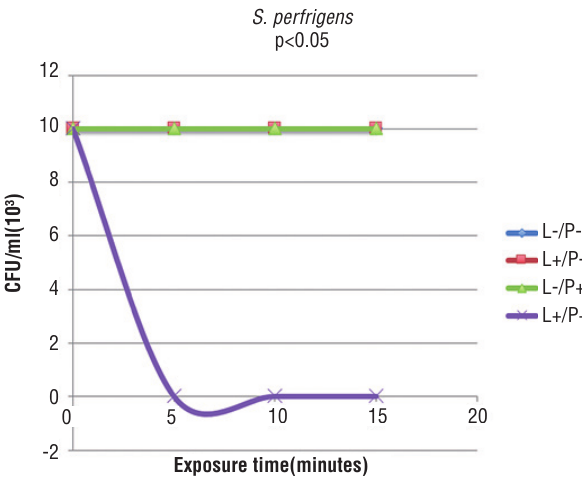
Figure 2 - Mean CFu/mL of C. perfrigens submitted to the following treatments: saline as control (L-/P-), laser and saline (L+/P-), photosensitizer (L-/P+), and laser and photosensitizer (L+/P+) (Tukey test, p <